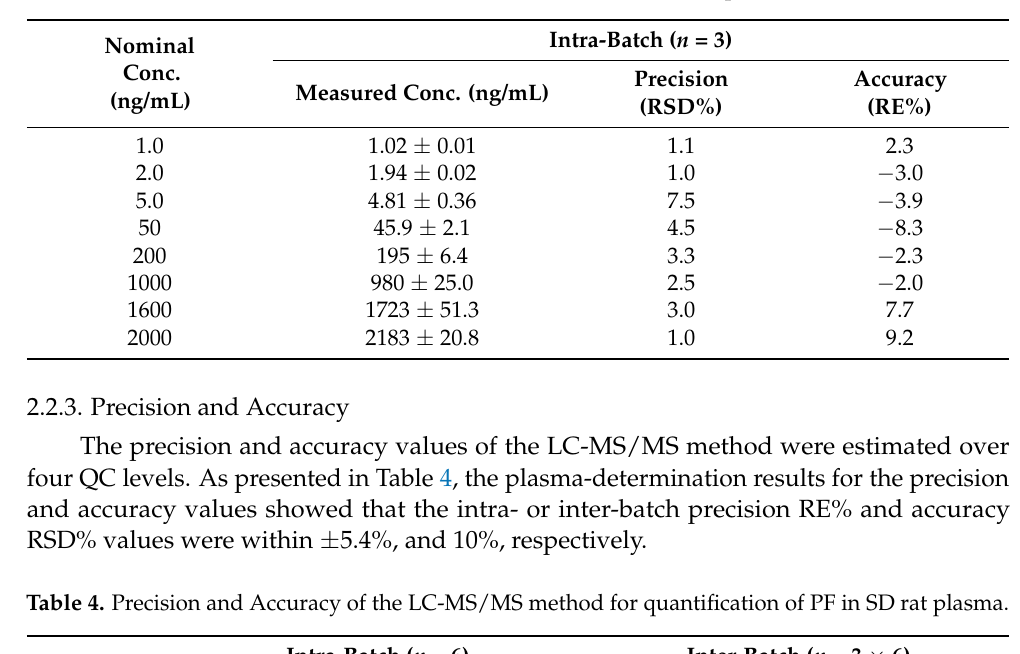
Table 4. Precision and Accuracy of the LC-MS/MS method for quantification of PF in SD rat plasma. Nominal Conc.